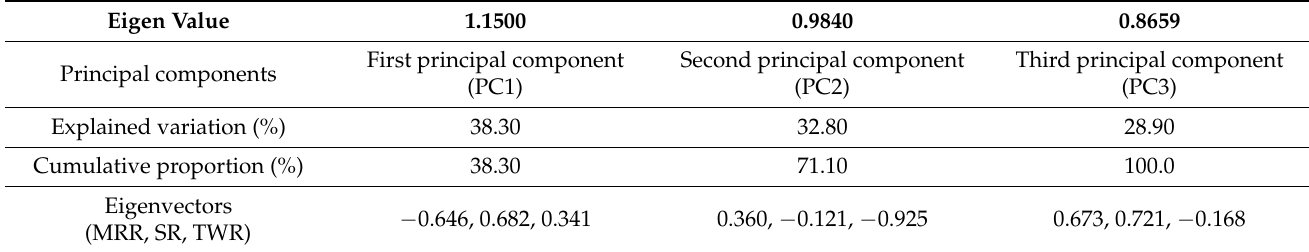
Table 11. Principle component analysis (PCA) analysis for weight